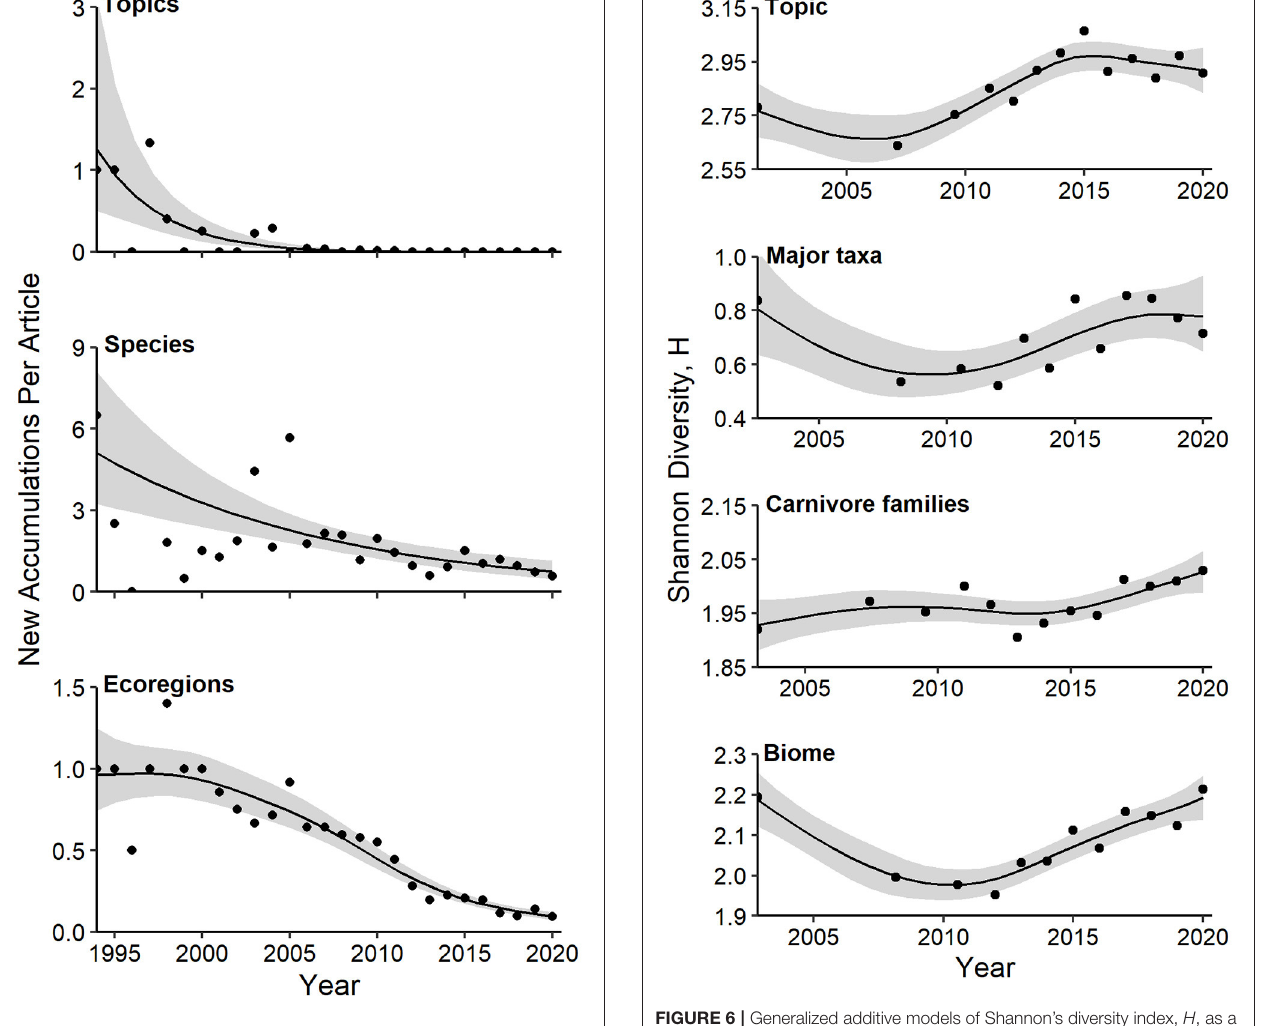
FIGURE 5 | Generalized additive models of annual per article rates of accumulation of topics, species, and ecoregions in camera-trapping articles from 1994 to 2020. Details of model fit are provided in the text and online Supplementary Table 1a . Shaded regions represent standard errors and points represent observed annual per article accumulation rates.